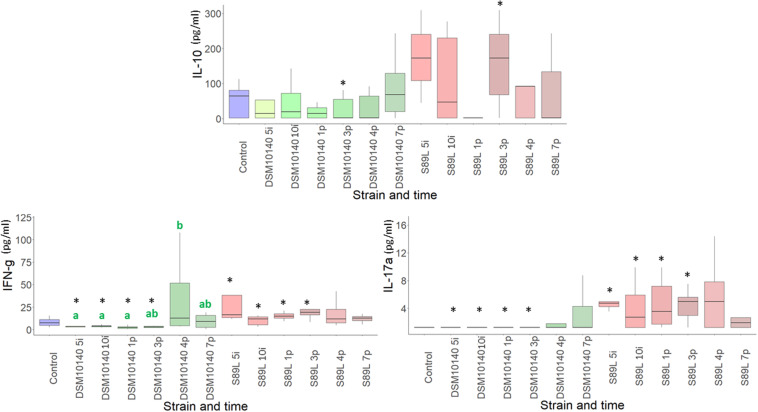
Box plot (median, interquartile range, minimum and maximum values) of the level (pg/ml) of IL-10, IFN-γ, IL-17A quantified in the blood serum of control mice group, as wells as in the groups fed with the non-ropy DSM10140 or with the ropy S89L Bifidobacterium animalis subsp. lactis strains at different sampling points (5i and 10i days of intervention, and 1p, 3p, 4p, and 7p days post-intervention). Within each strain-treatment group, samples (days) that do not share a common letter are statistically different (p < 0.05). Within each treatment day, the statistical differences between the DSM10140 and S89L groups are marked with an asterisk (*p < 0.05). For information about other cytokines, see Supplementary Table 1 in the Supplementary Material.